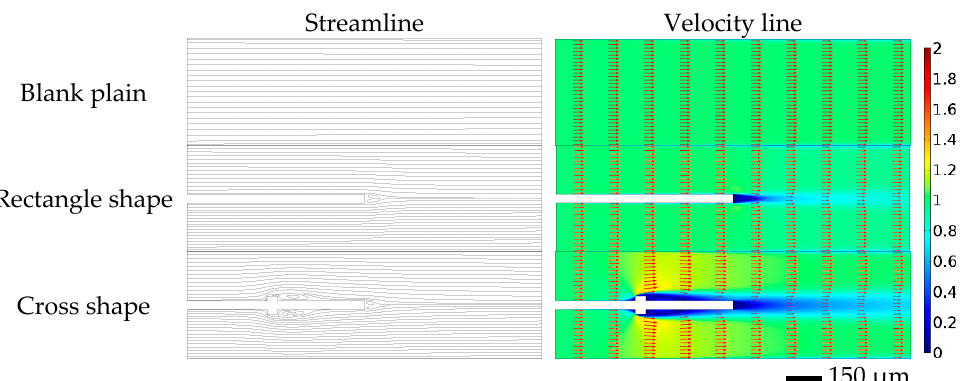
Figure 4. Velocity vector map (right) and corresponding streamline (left) of the plain blank microchannel, the microchannel with microstructure of the rectangle shape, and the microchannel with microstructure of the cross shape (velocity vector: red arrows; streamline: black lines).